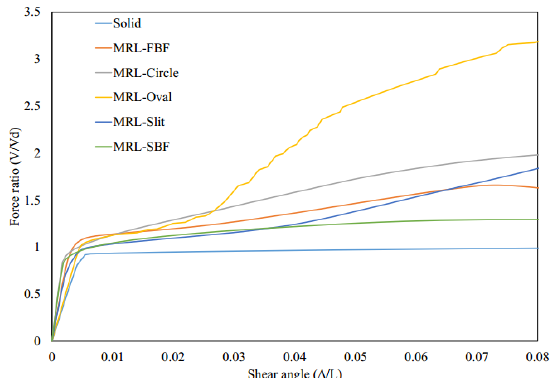
Figure 19. Pushover analyses curves for various innovative MRL fuse systems.